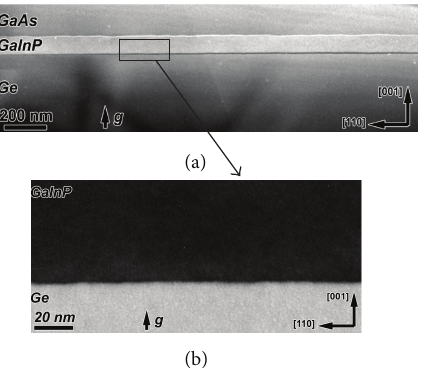
Figure 5: Bright field TEM image of (1–10) cross-section of a SC structure (a) and dark field TEM image of (1–10) cross-section of the GaInP/Ge interface (b). The TEM images were obtained in two- beam condition with a diffraction vector 𝑔 = (002) .